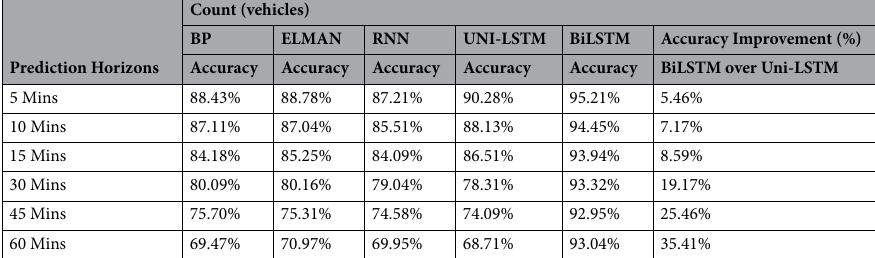
Table 3. Count performance for different prediction horizons